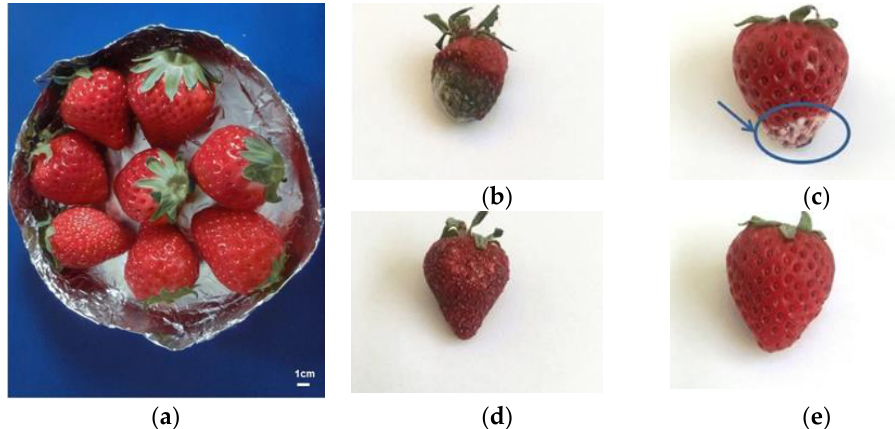
Figure 9. The results of the antibacterial assessment of five strawberry groups: ( a ) initial state; ( b ) no cover; ( c ) plastic cover; ( d ) coating of chitosan solution; ( e ) covered with chitosan-derivative electrospun nanofiber membrane. Adapted from [187], originally published under a CC-BY 4.0 license.